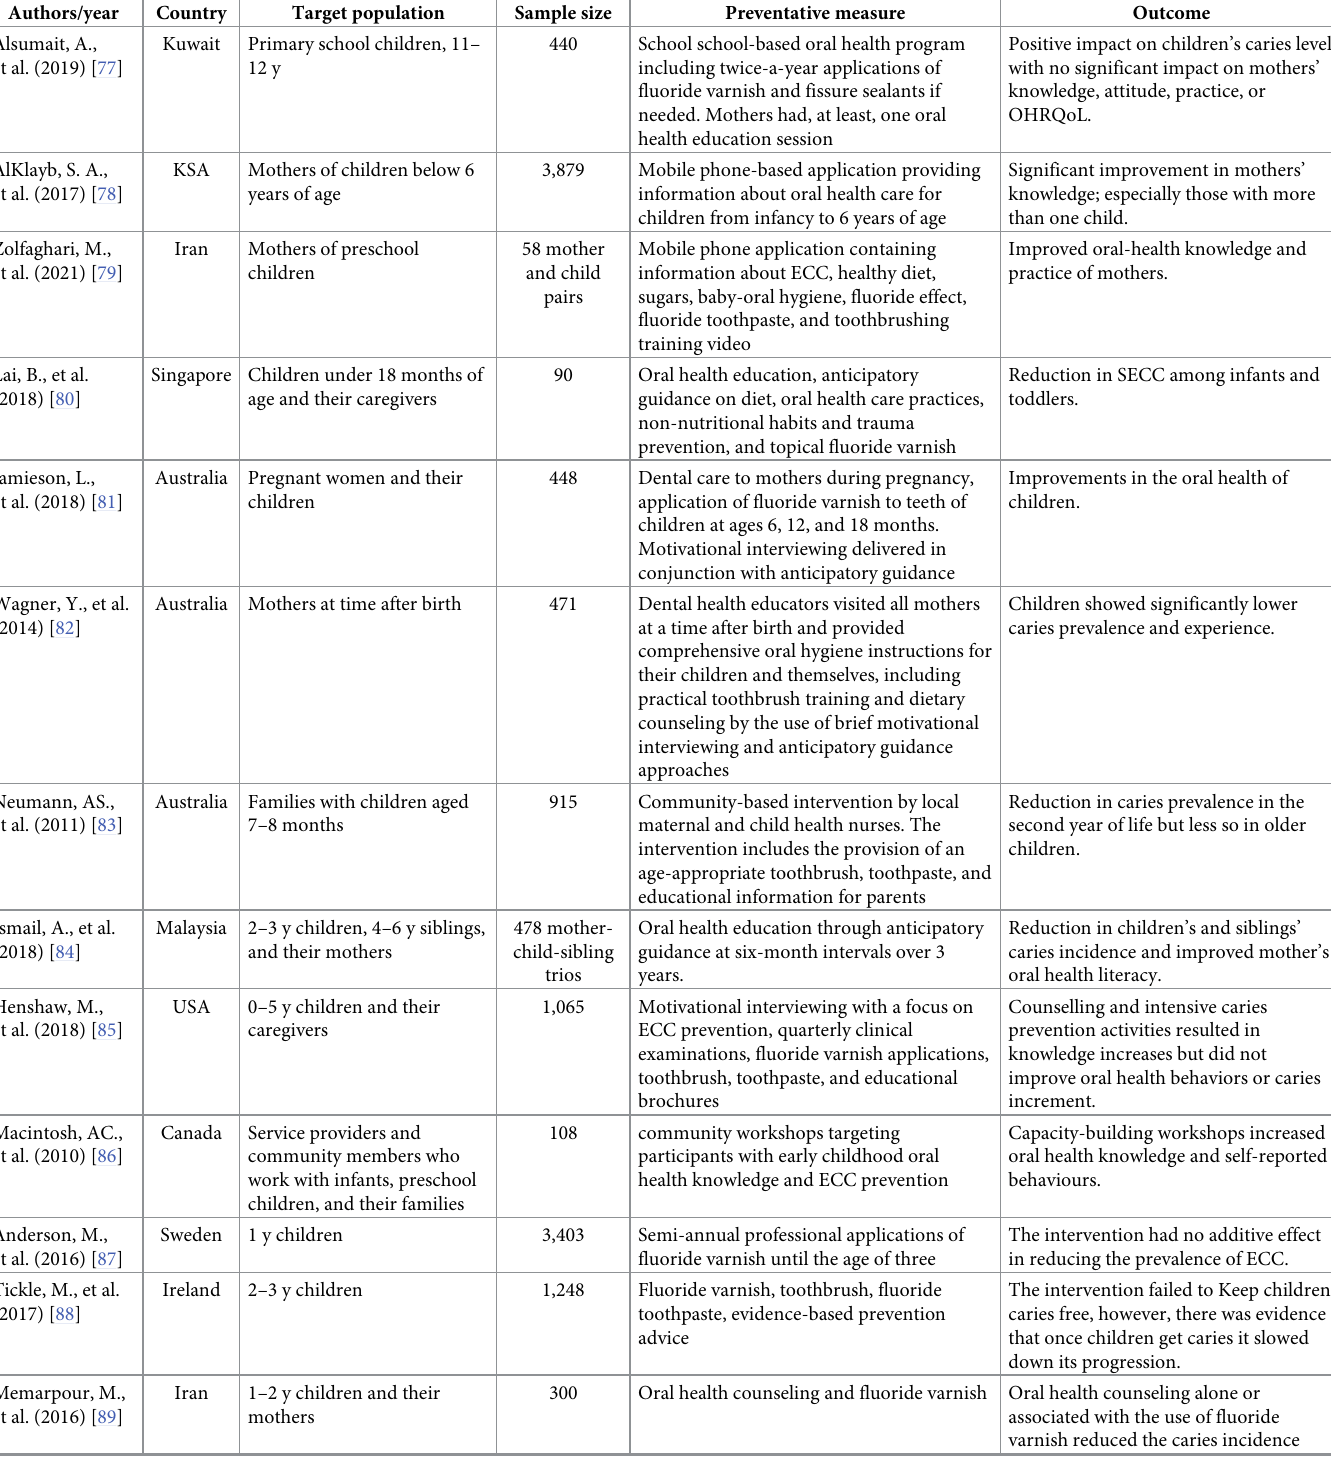
Table 3. ECC oral health prevention programs and their reported